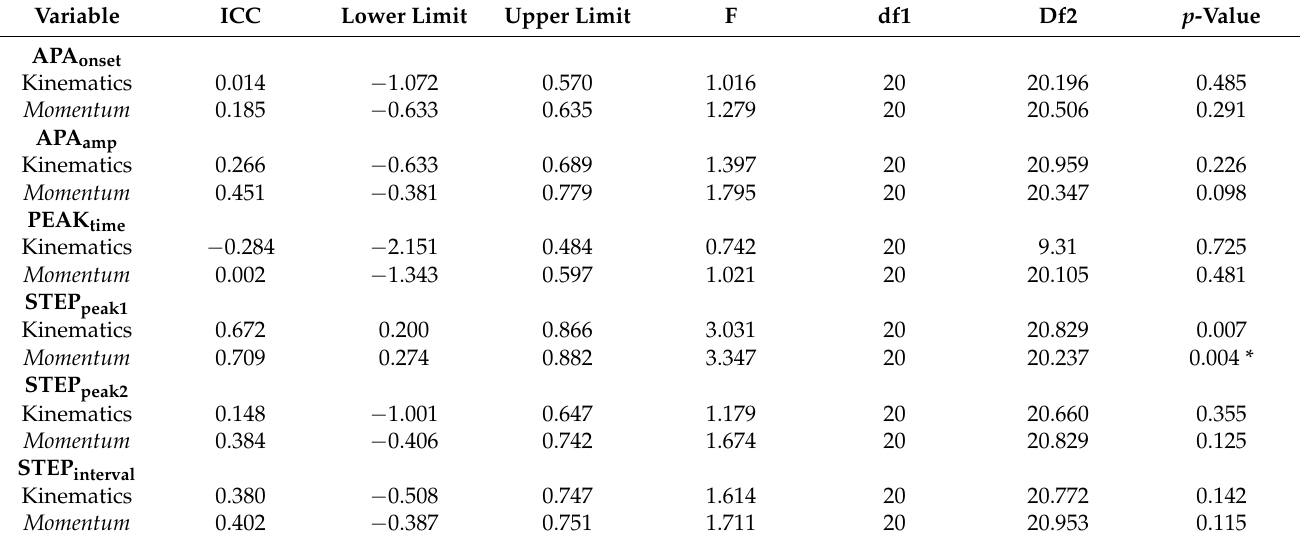
Table 1. Intrasession intraclass correlation coefficient (ICC) results of all variables analyzed by kinematics and Momentum app. Asterisk (*) represents values that present statistical significance ( p ≤